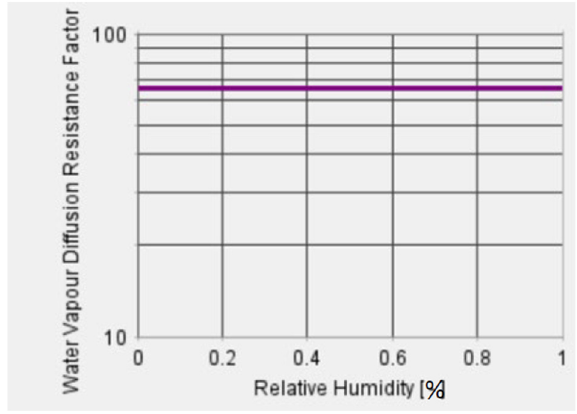
Figure 1. Snapshot of water vapour diffusion resistance factor showing a single point value.